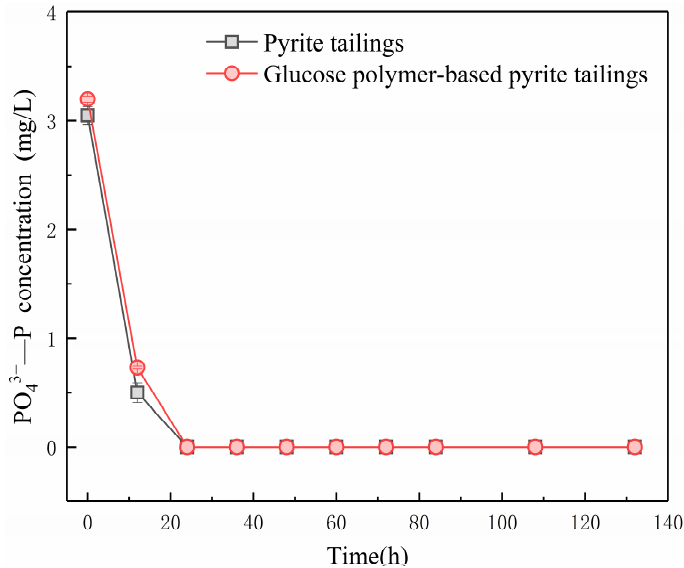
Figure 7. Variation diagram of PO 43 − -P concentration in denitrification system before and after pyrite tailings coating.